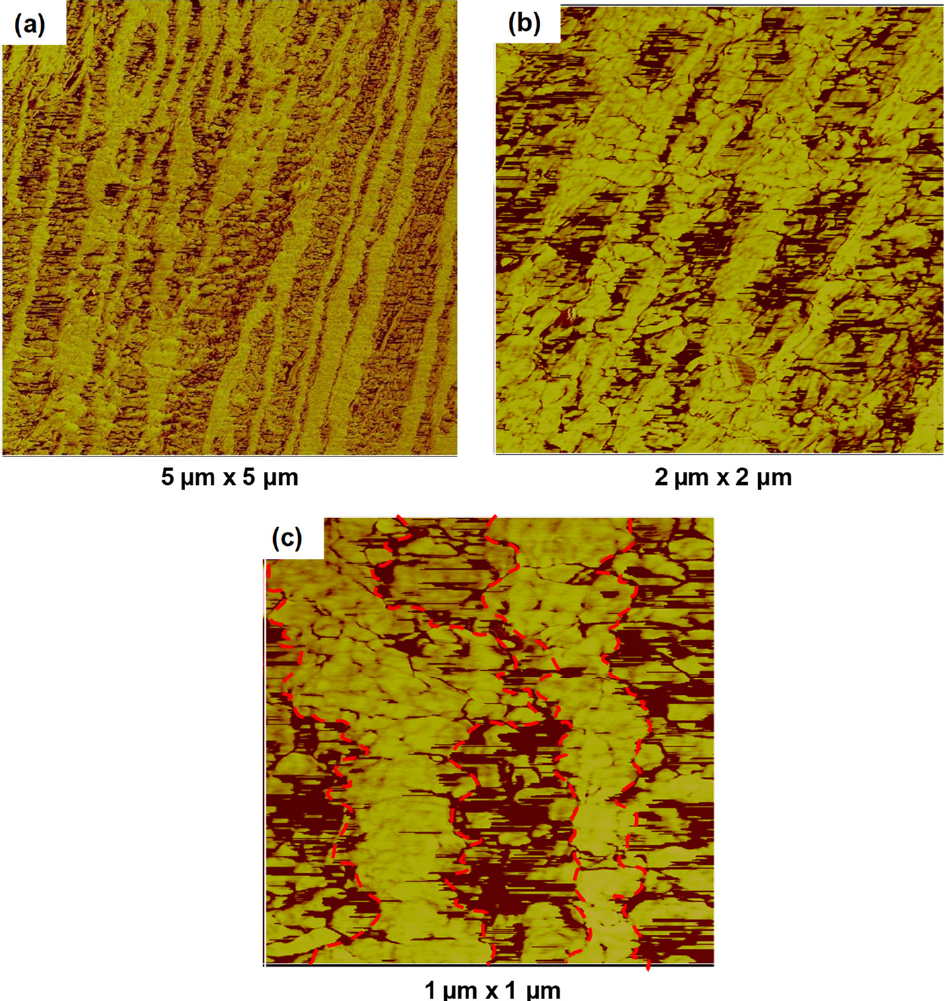
Figure 2. ( a , b ) AFM phase images of the domain morphology of the unoriented tapes parallel to the extrusion direction. Domains with lighter colors (higher moduli) are PP; domains with darker colors (lower moduli) are HDPE. Superimposed red dash line in ( c ) highlights the PP-HDPE interfacial region.